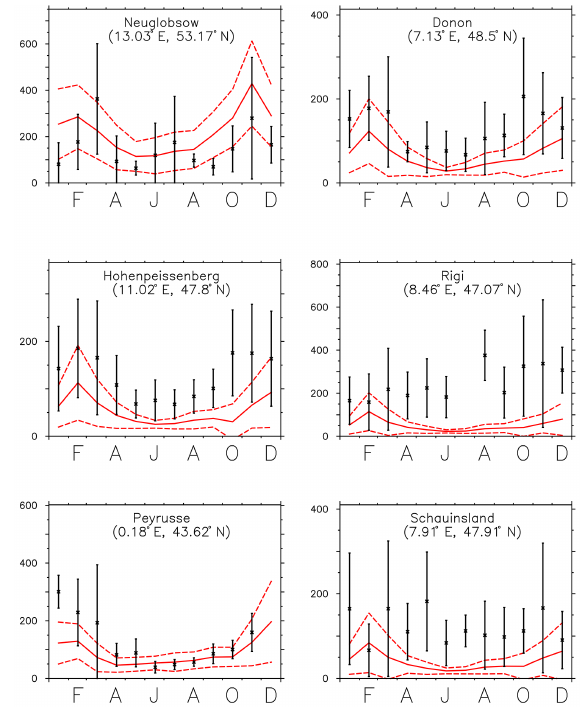
Figure 5. EMEP observations of toluene for six different loca- tions for the year 2005 (monthly average) (in black) and the simu- lated toluene mixing ratios for the RCP simulation (in red), both in pmolmol − 1 . Error bars show standard deviation of the observations and red dashes show the standard deviation of the model